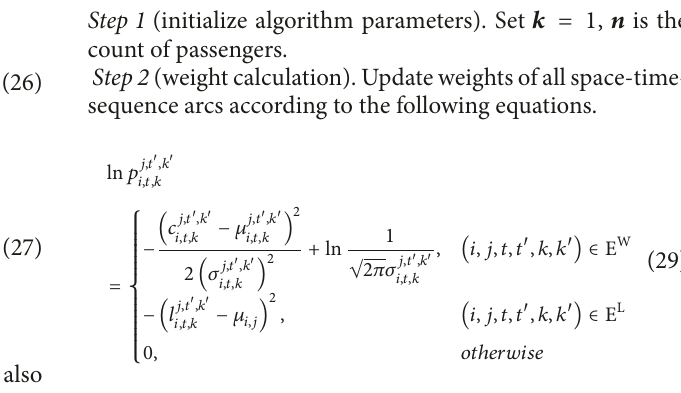
Algorithm 2 (passenger’s travel-patterns estimation